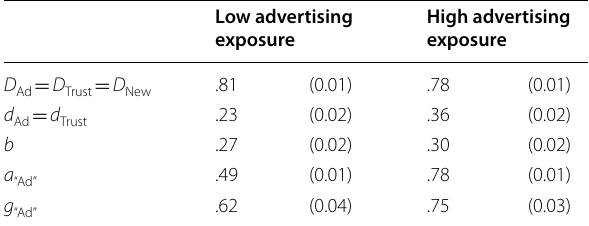
Table 1 Parameter estimates for item memory for the statements, source memory, and guessing as a function